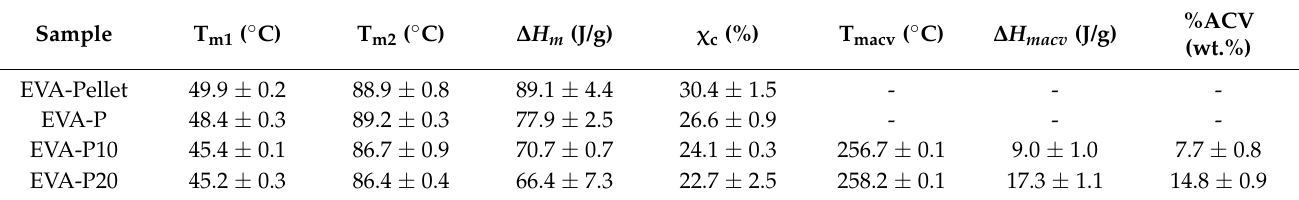
Table 2. Thermal behavior data obtained from DSC heating cycle for EVA and EVA/ACV samples.